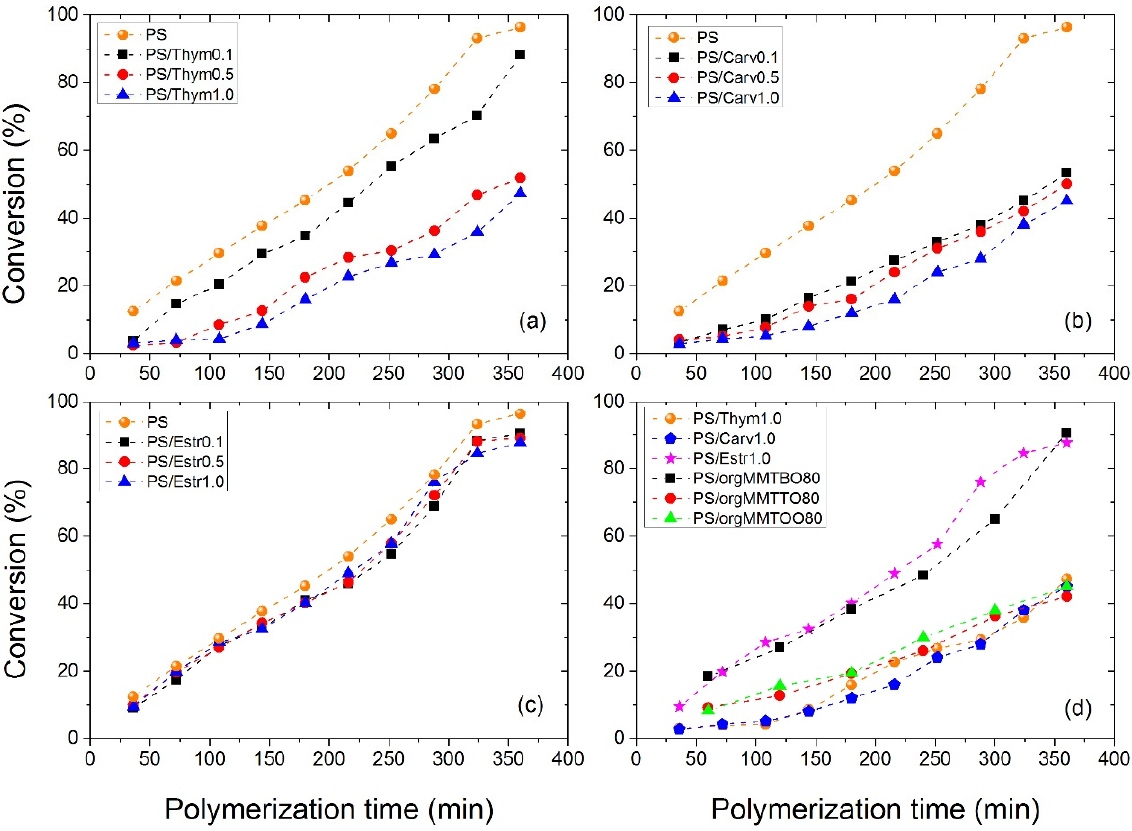
Figure 7. Variation of monomer conversion with time during polymerization of styrene with 0.1, 0.5 and 1.0 wt % of model thymol (a), carvacrol (b) and estragol (c) at 80 °C with 0.03 mol/L initial BPO concentration. The downright figure (d) presents comparative results of model compounds at 1.0% with orgMMTBO80, orgMMTTO80 and orgMMTOO80. Table 3. Number- and weight-average molecular weights ( n M , w M ), as well as polydispersity